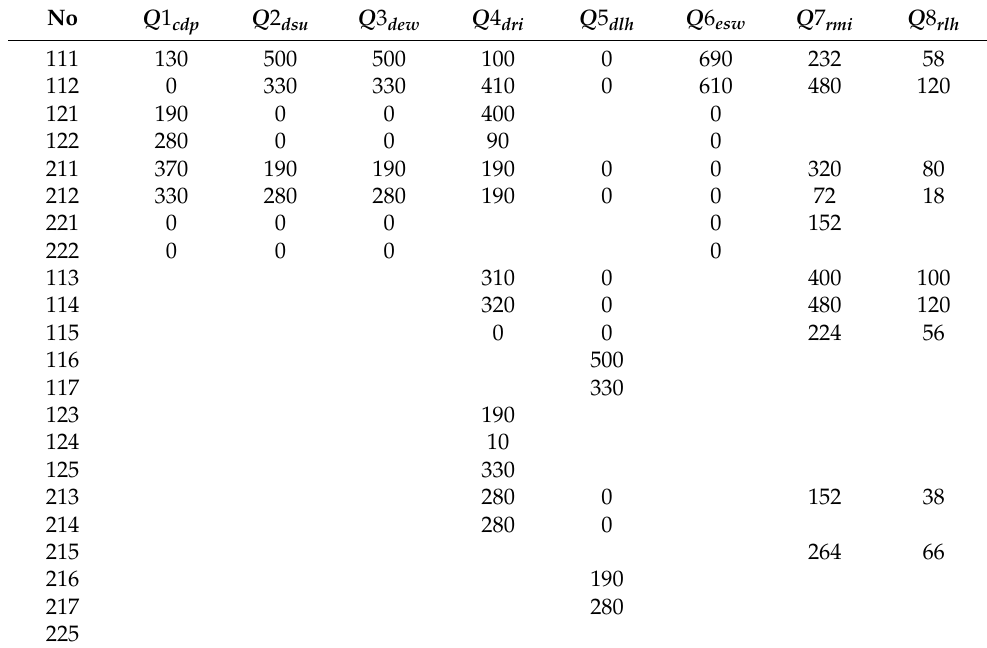
Table 18. The flow of materials and components (1st scenario).